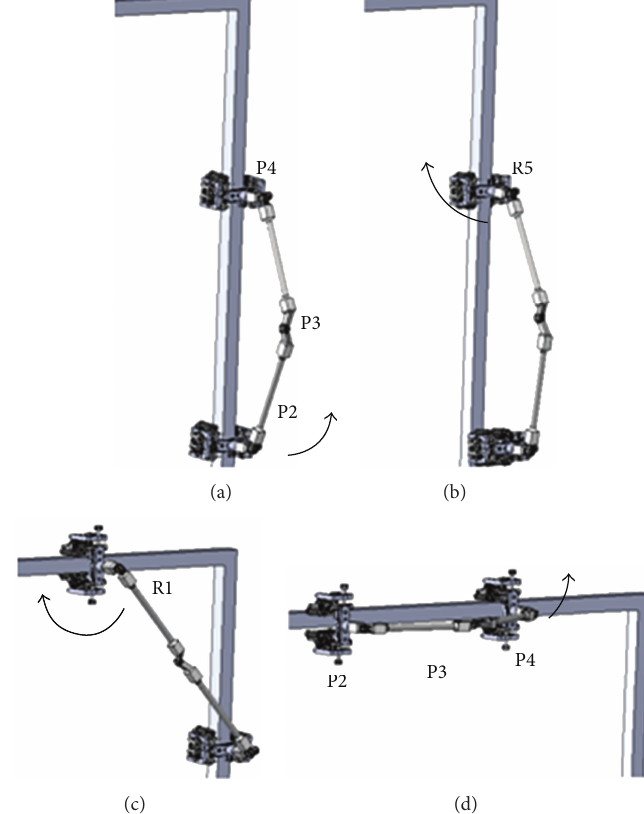
Figure 8: The conventional gait for